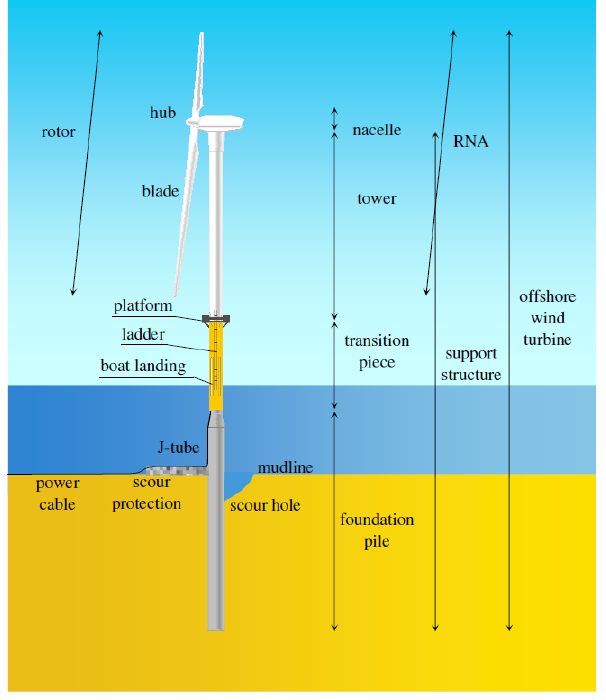
Figure 2. Components of an OWT relevant for support structure design (Van der Tempel, 2006).